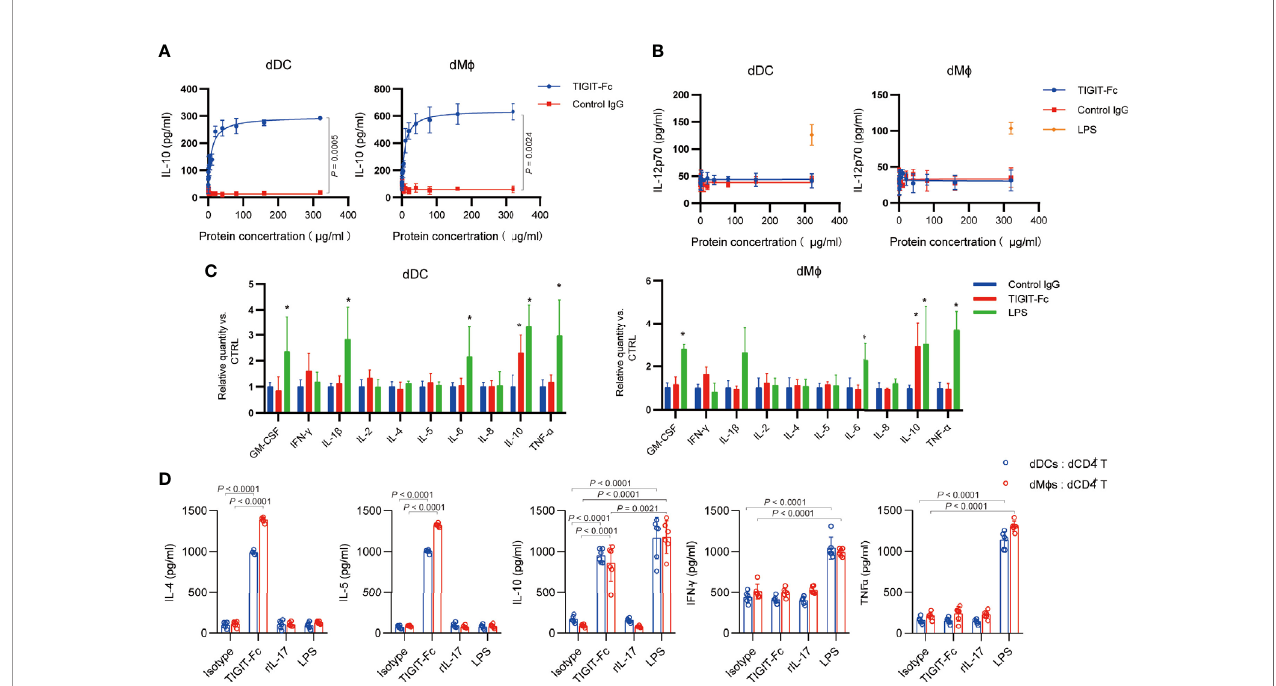
FIGURE 2 | Immunomodulatory effect Biological effect of TIGIT fusion proteins in vitro . (A) , ELISA of IL-10 in human dDCs and dM f s after the indicated treatment for 48 h with different concentration of TIGIT-Fc or control IgG, n = 4. (B) , ELISA of IL-2 in human dDCs and dM f s after the indicated treatment for 48 h with different concentration of TIGIT-Fc or control IgG. LPS served as a positive control. n = 4. (C) , Cytokine levels in the supernatants of human dDCs and dM f s were determined by multiplex bead array. The relative level was calculated as the ratio to the control IgG treatment, n = 4. (D) , The human dDCs and dM f s were treated with TIGIT-Fc, IL-7, or LPS, respectively, for 24 h, washed and cocultured with decidual CD4 + T (dCD4 + T) cells. Thereafter, the T cells were transferred to a new 96-well round-bottom plate precoated with anti-CD3 and anti-CD28 (2 m g/ml each) and cultured for 24 h. The cytokine secretion of the CD4 + T cells was then determined by ELISA, n = 6. Data are the means ± s.d. (A – D) . P values were from a nonparametric t test (Mann-Whitney test) (A, B) , and two-way ANOVA followed by the Bonferroni post-test (C, D) . *: P < 0.05 (C)